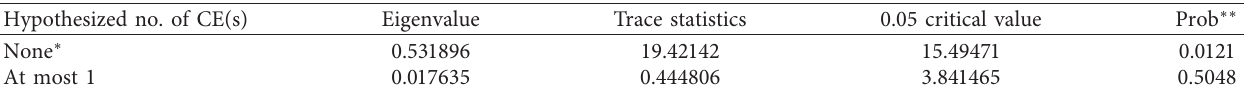
Table 3: Johansen cointegration test.